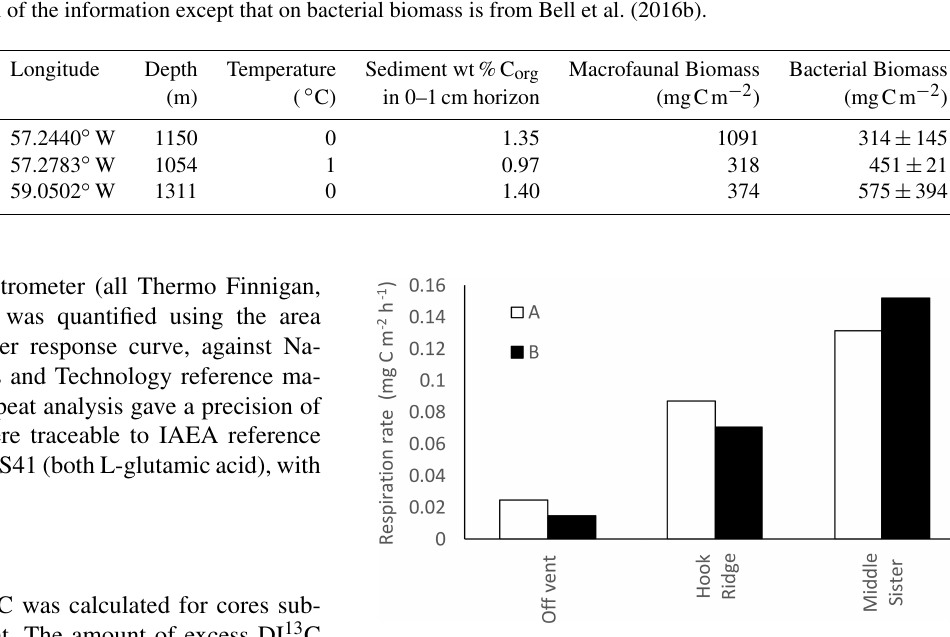
Figure 2. Respiration rates measured in algae addition experiments. A and B refer to the two replicate cores in each